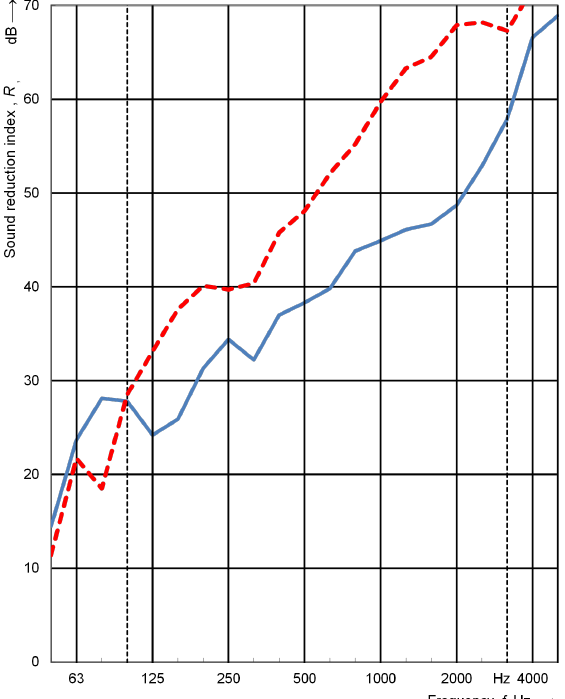
Figure 10. Sound reduction index of walls with ETICS: wood fibre – the solid blue curve, mineral wool – the dashed red curve.